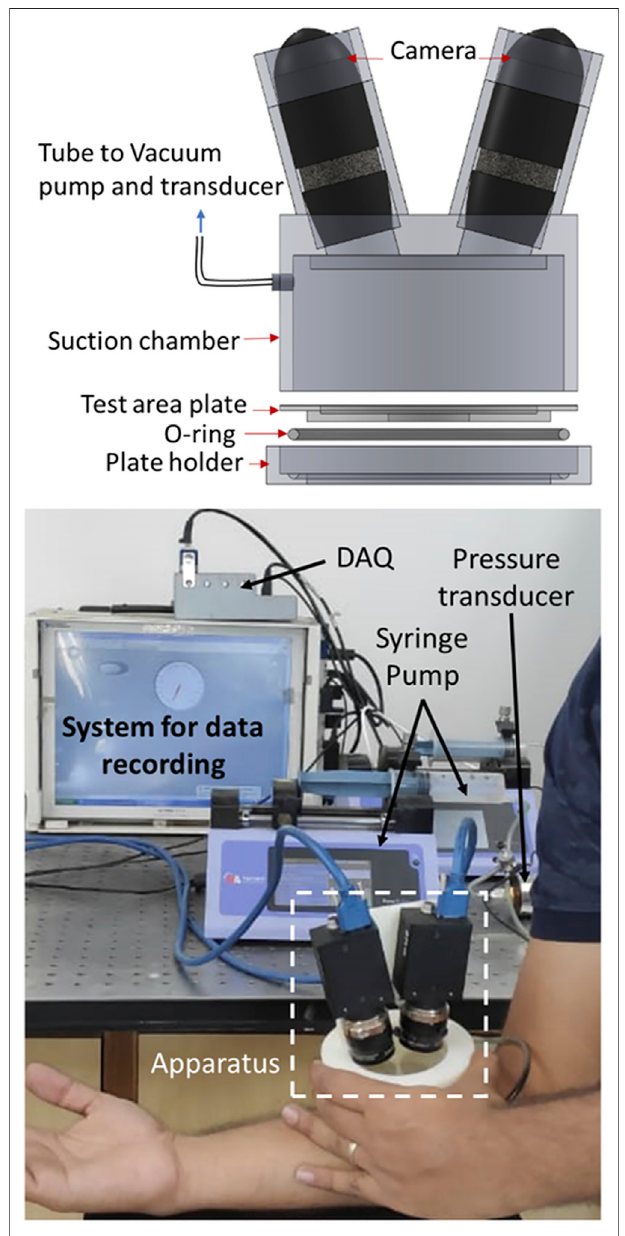
FIGURE 1 | The schematic diagram and photograph of full- fi eld measurement suction apparatus. The apparatus consists of a suction chamber,twocameras,avacuumpump,pressuretransducer,testareaplate, O-ring, and plate holder.